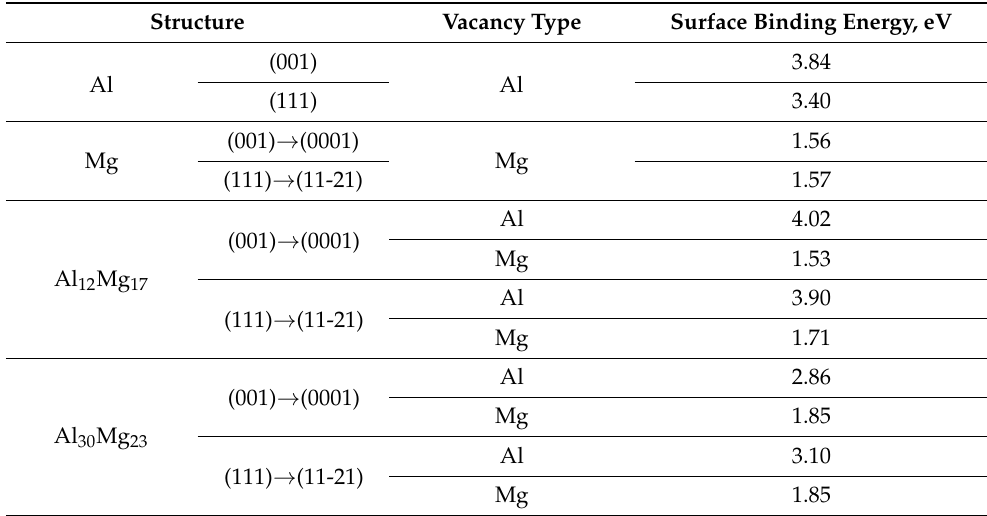
Table 4. The values of the binding energies in Al, Mg and the intermetallic phases Al 12 Mg 17 and Al 30 Mg 23 (close to Al 3 Mg 2 ), calculated via the DFT